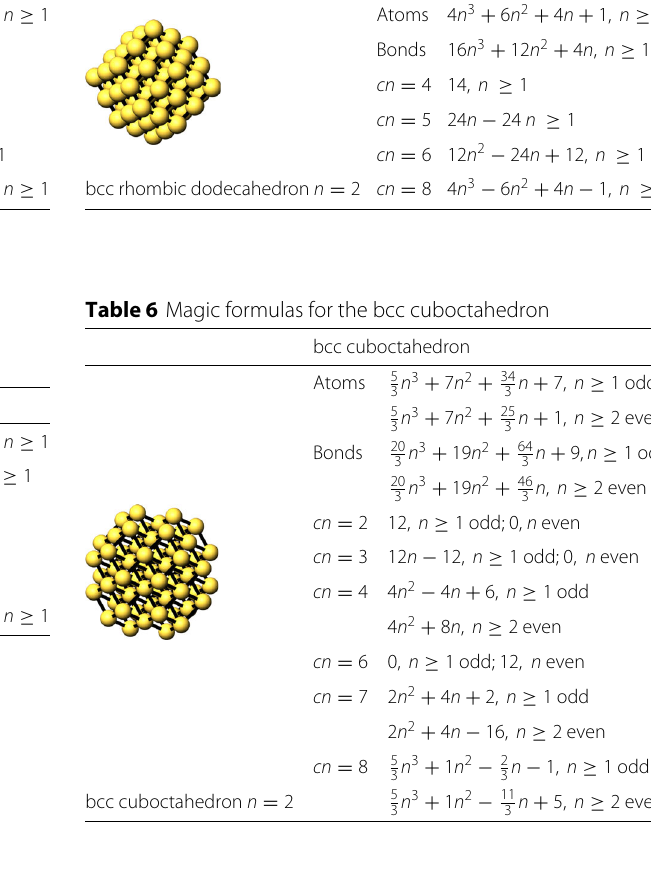
Table 4 Magic formulas for the bcc truncated octahedron